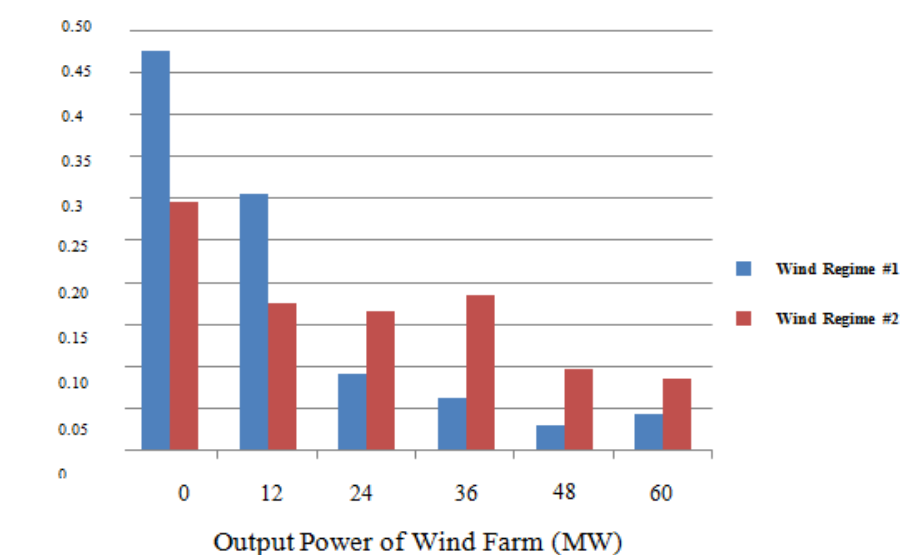
Figure 2. Histogram of 60 MW wind farm output power for two wind regimes.